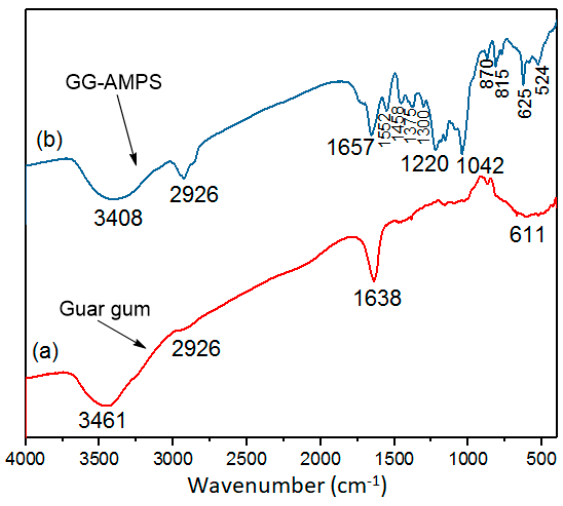
Figure 2. IR spectrum of GG-AMPS.